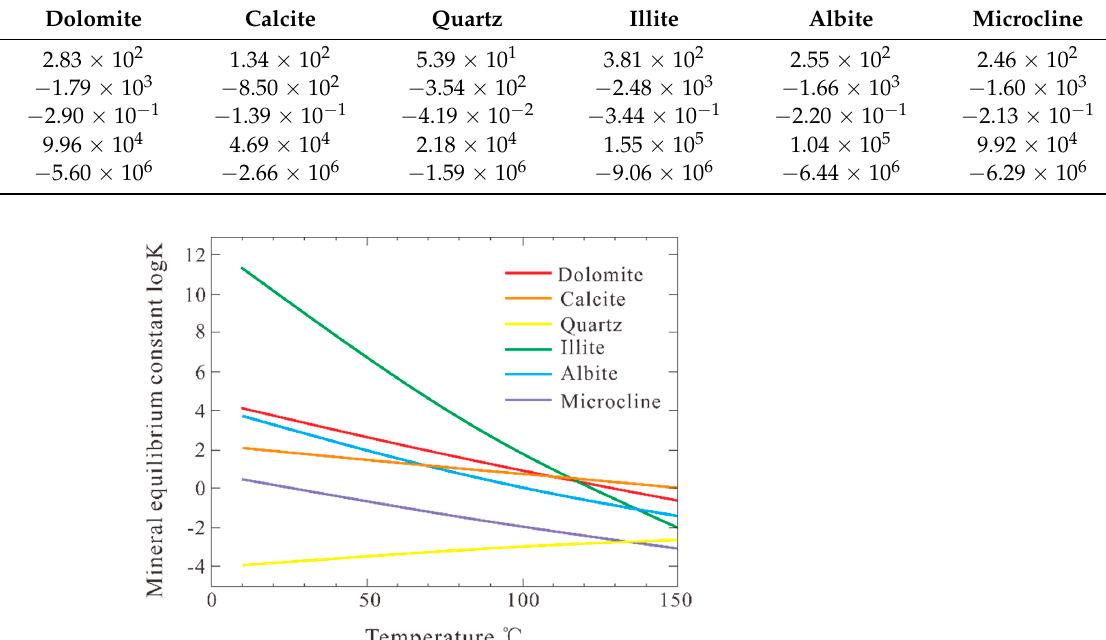
Table 4. Calculation coefficients of main mineral equilibrium constants.